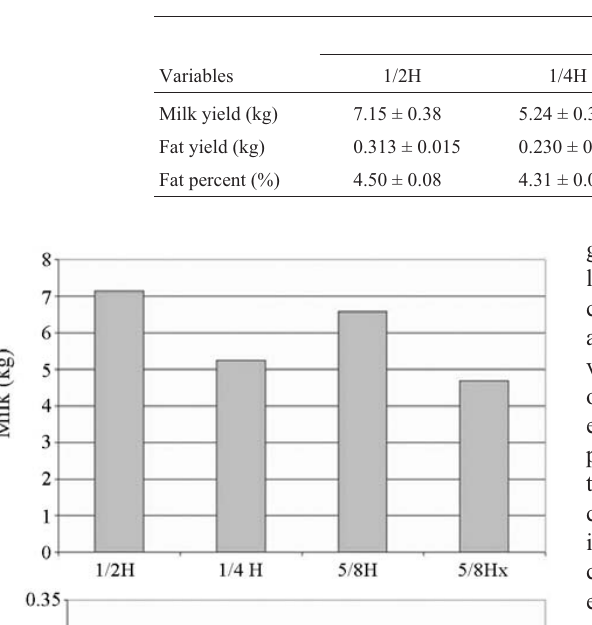
Table2 -LeastsquaresmeansofthefourgeneticHolstein-Gircrossbreedgroups(1/2H,1/4H,5/8H,5/8H interse )formilkyield(MY),fatyield(FY)and fat percentage (FP) based on monthly test day data.